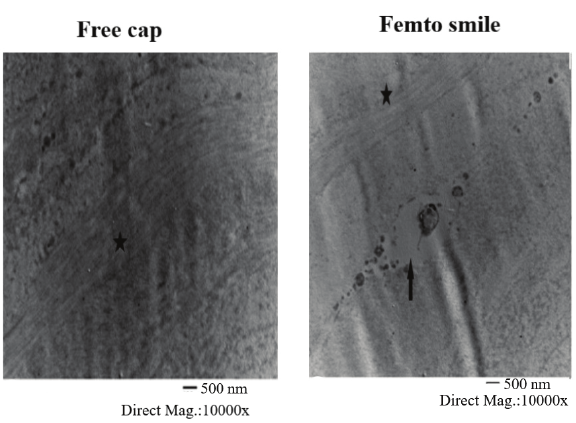
Figure 2. Transmission electron micrograph of (a) free cap showing more regular arrangement of the stromal lamella and intact collagen bundles and (b) Femto SMILE showing disruption of the collagen arrays (*) as well as pyknotic keratocyte